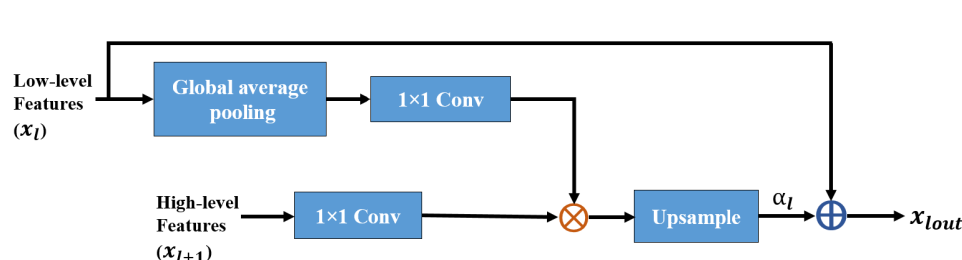
Figure 3. Schematic of the proposed global attention module (GAM) integrated into the proposed brain segmentation architecture.